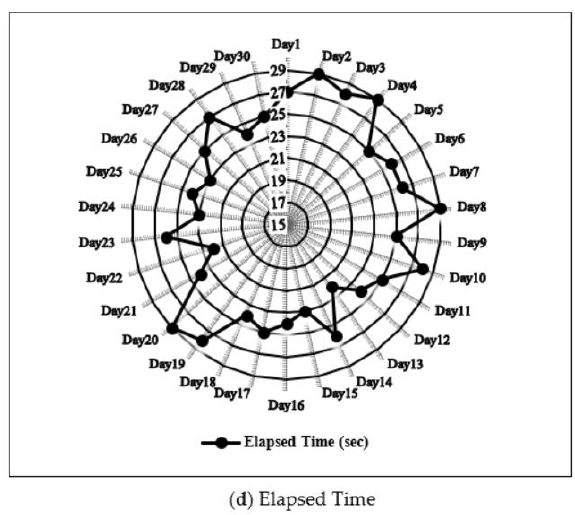
Figure 9. Evaluation outcomes of the proposed ransomware streaming analytics model in the realistic test.